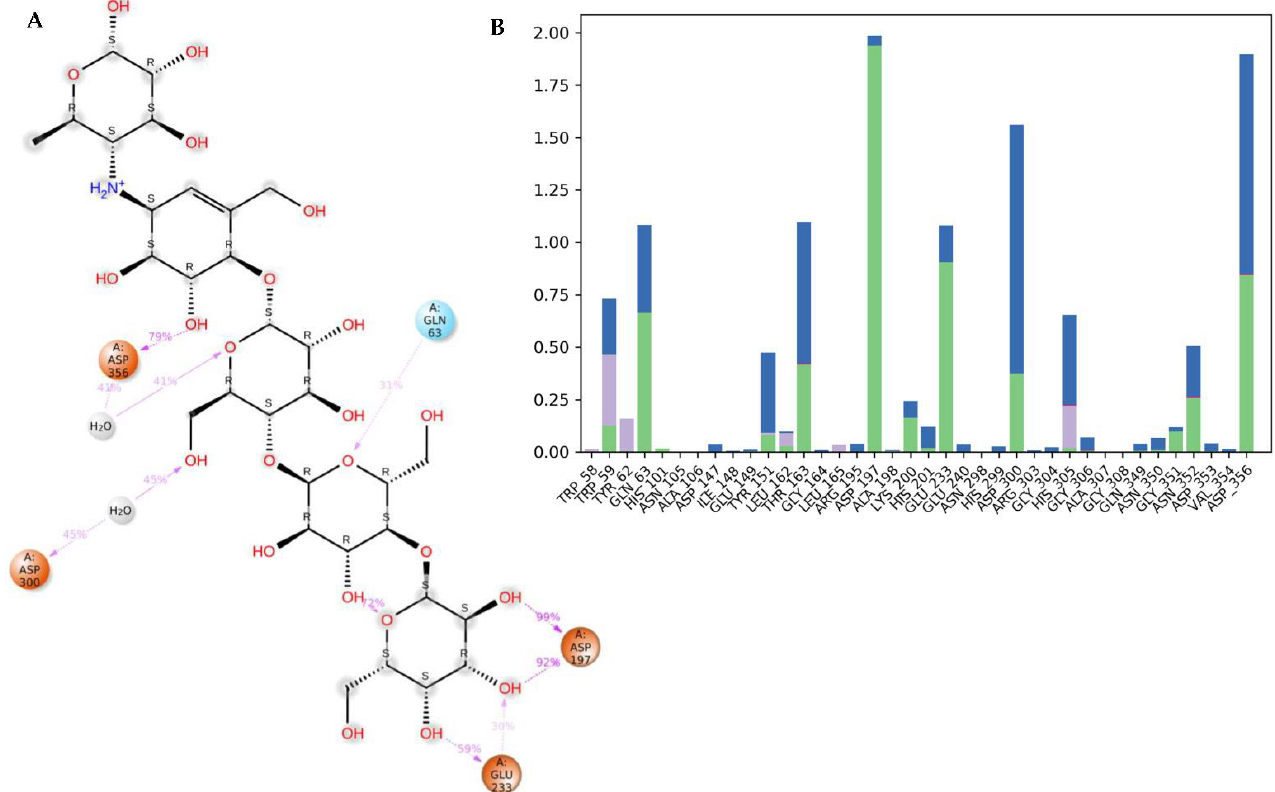
Figure 11. Analysis of molecular interactions and types of contacts with alpha-amylase after MD simulation. ( A ) Detailed schematic interaction of acarbose with the binding site residues of alpha- amylase in color scheme, where orange represents the charged, blue represents the polar, and light green represents the hydrophobic residues (PDB ID:4GQR). ( B ) Normalized stacked bar chart of alpha-amylase binding site residues interacting with acarbose showing the main types of bonding interaction: hydrogen bonds (green), hydrophobic (violet), and water bridges (blue).